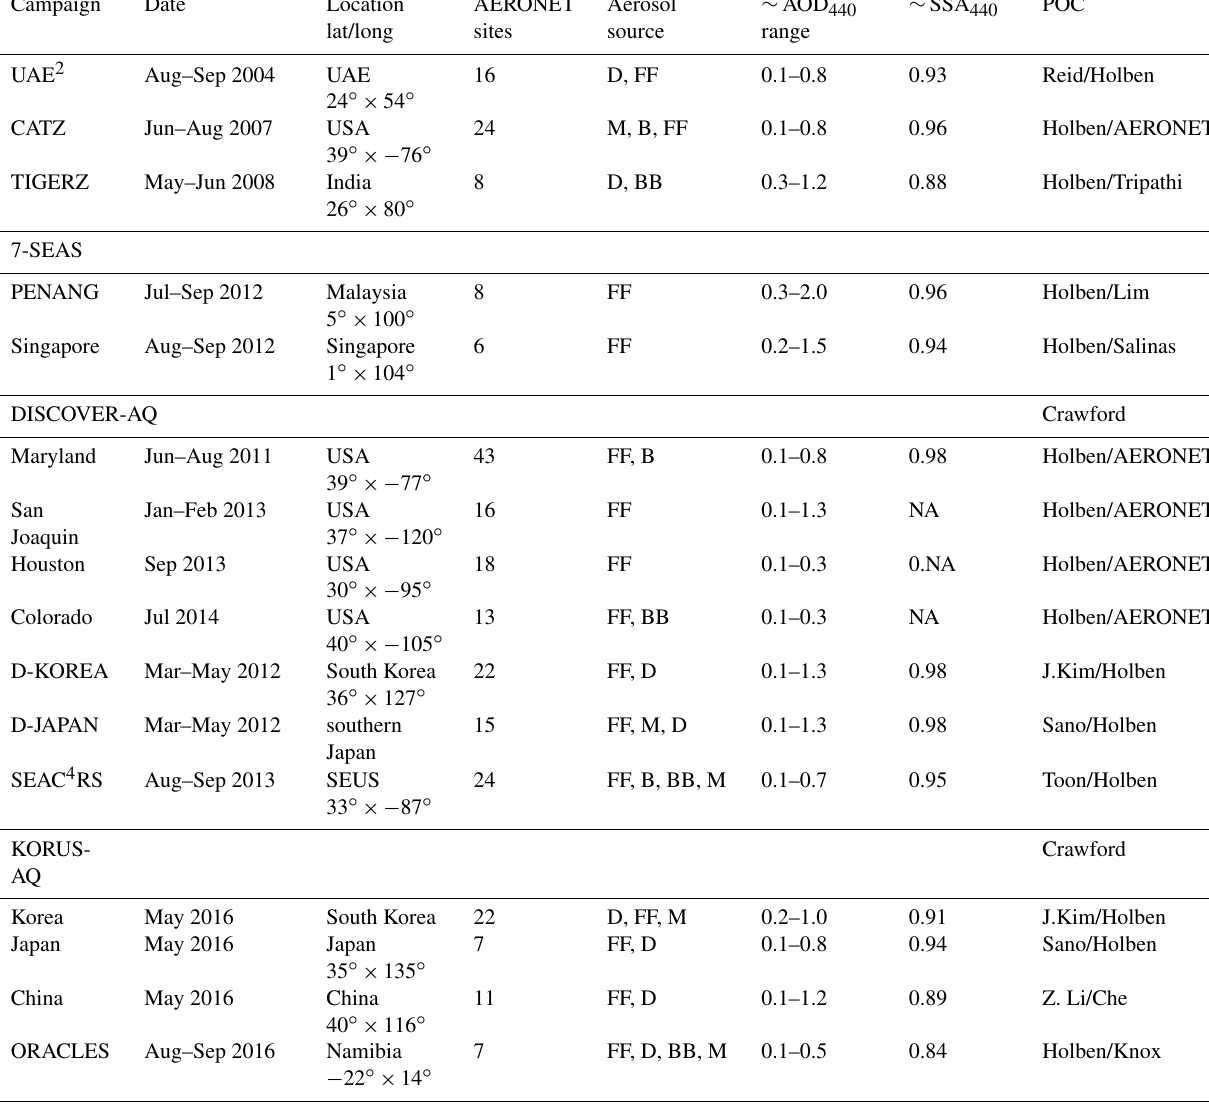
Table 3. DRAGON campaign summaries. D: dust; FF: fossil fuel; B: biogenic; BB: biomass burning; M: maritime. Because of the time period of measurement and the number and location of instruments and variable aerosol types transported by synoptic-scale meteorology, AOD and particularly SSA averages are approximate. Most campaigns are referenced at: https://aeronet.gsfc.nasa.gov/new_web/campaigns.html, where DRAGON data sets are also available with detailed point of contact (POC)